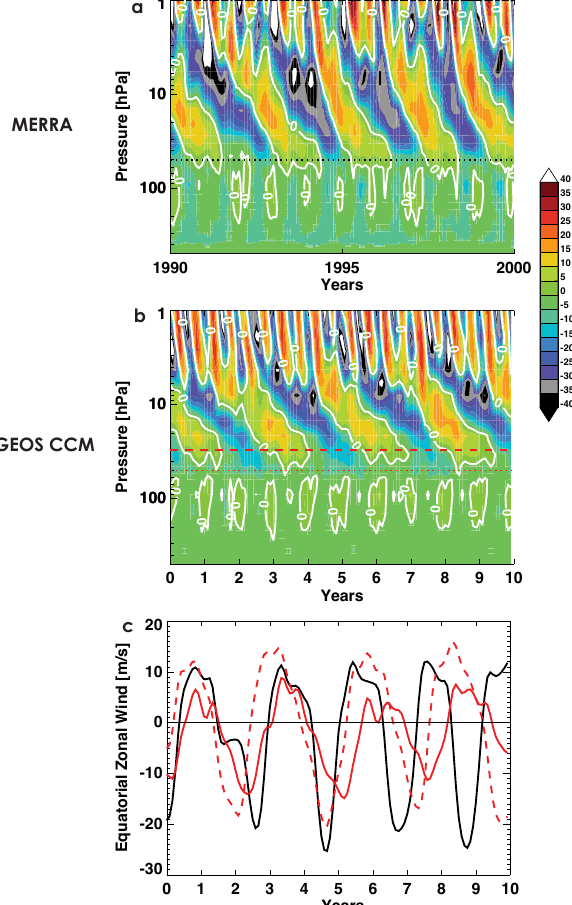
Fig. 2. Equatorial (4 ◦ S–4 ◦ N) zonal mean zonal wind (ms − 1 ), as a function of time and altitude: (a) 1990 through 1999 in MERRA; (b) 10 years of the ENSON simulation. White contours denote the zero wind line. The black dotted line highlights the 50hPa level in MERRA; the red dotted (dashed) line highlights the 50hPa (30hPa) level in the ENSON simulation. (c) Smoothed timeseries of equa- torial zonal wind at 50hPa in MERRA (black solid line); 50hPa in the ENSON simulation (red solid line); 30hPa in the ENSON simulation (red dashed line).